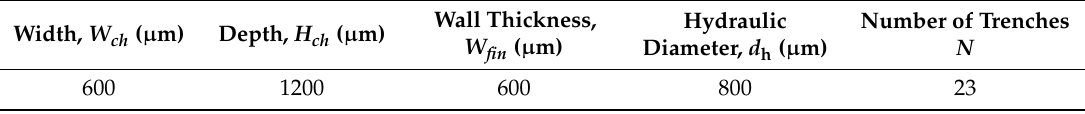
Table 2. Structural parameter of porous